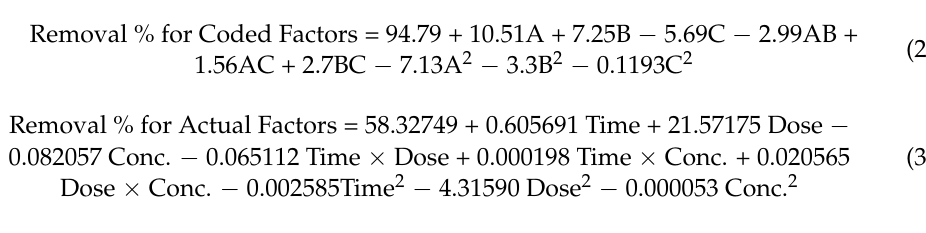
Table 6. Experimental design for adsorption of AO7 dye on activated carbon. Independent Factors Response